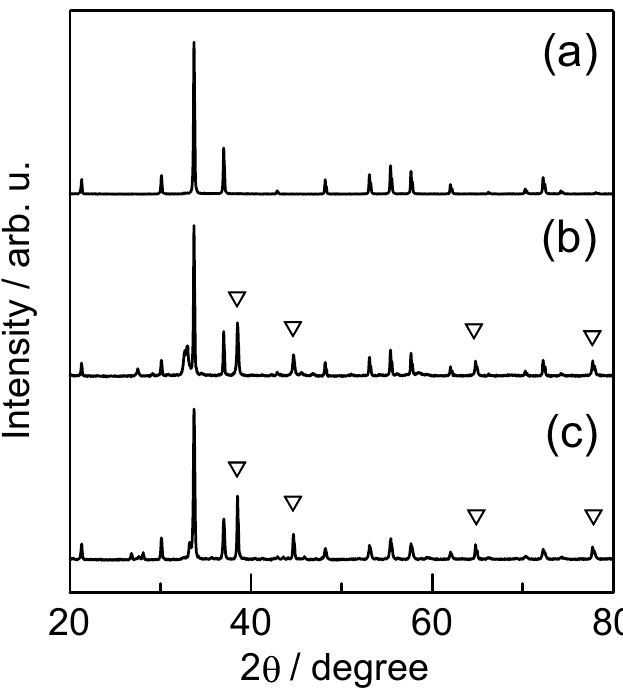
Figure 4. XRD patterns for silver phosphate coating obtained by calcination at ( b ) 300 °C and ( c ) 500 °C. An XRD pattern for ( a ) the dried paste before calcination is also shown.